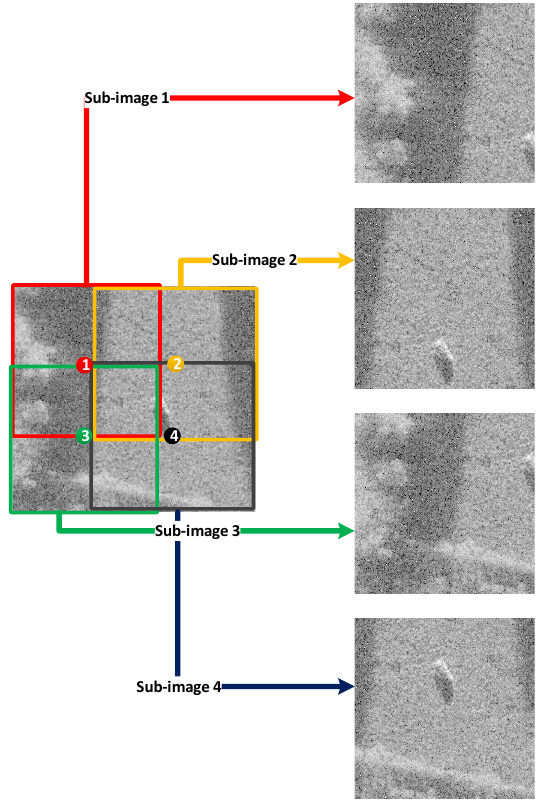
Figure 2. Diagram of fast sliding.